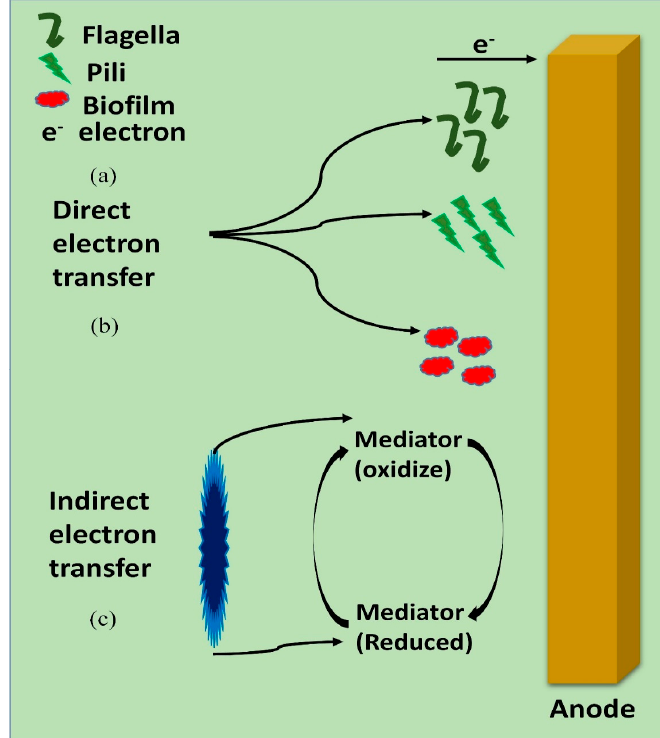
Figure 3. Proposed electron transfer mechanisms utilized direct electrons ( a , b ) and indirect electrons transfer ( c ) through electrogens using benthic microbial fuel cell.